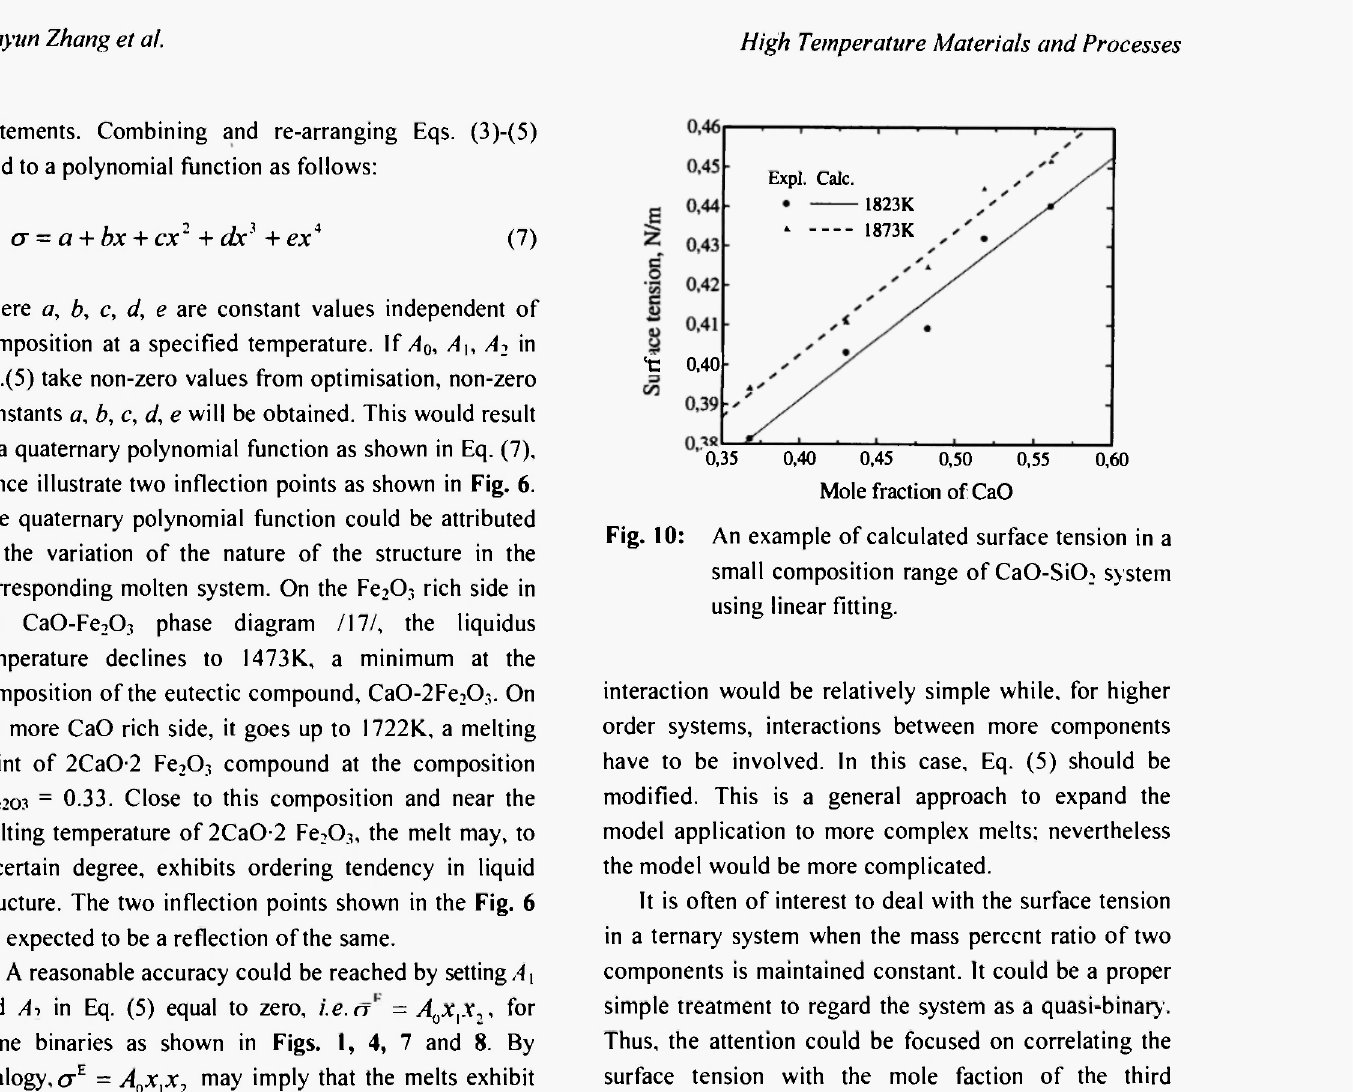
11 demonstrates the variations of